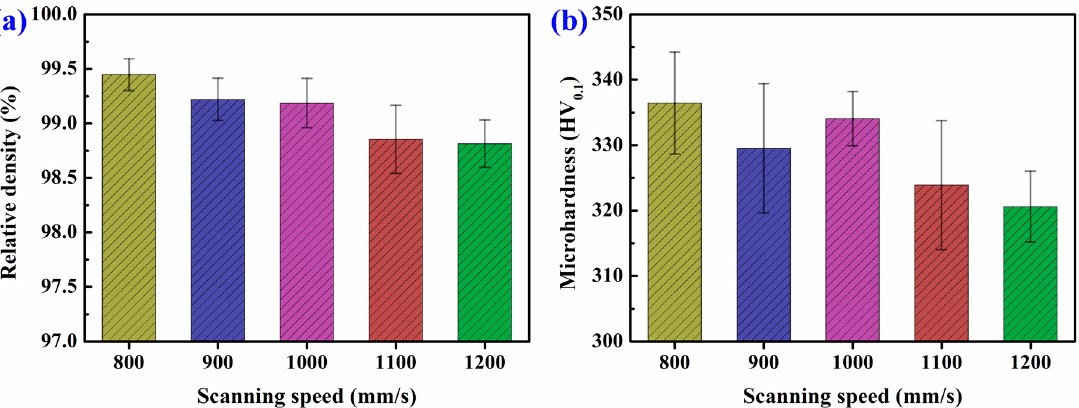
Figure 3. The density ( a ) and microhardness ( b ) of as-LPBFed TA15 titanium alloy under various scanning speeds.